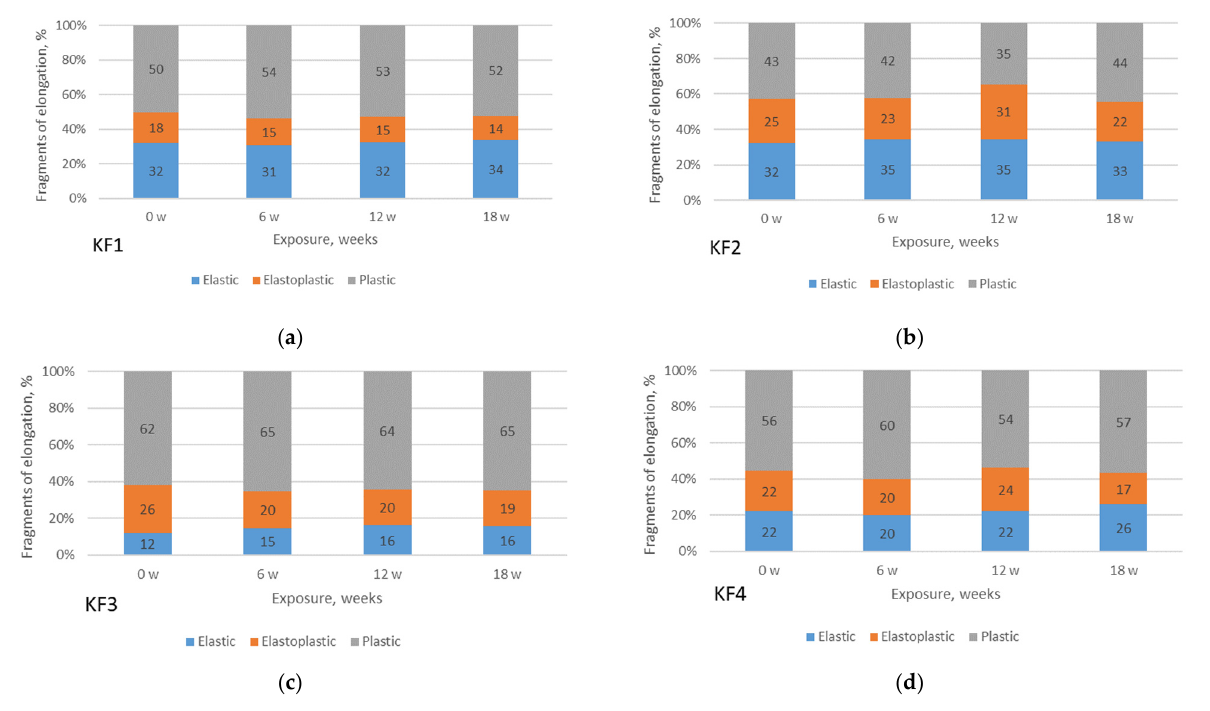
Figure 10. Fragments of elongation of materials exposed to aging outdoors: ( a ) material KF1; ( b ) material KF2; ( c ) material KF3; ( d ) material KF4.